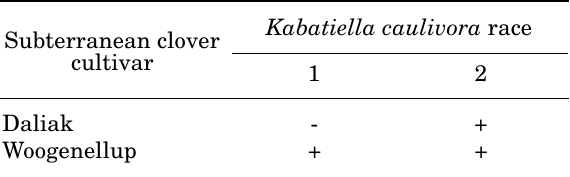
Table 1. Types of reactions observed between two races of Kabatiella caulivora and two cultivars of subterrane- an clover ( Trifolium subterraneum